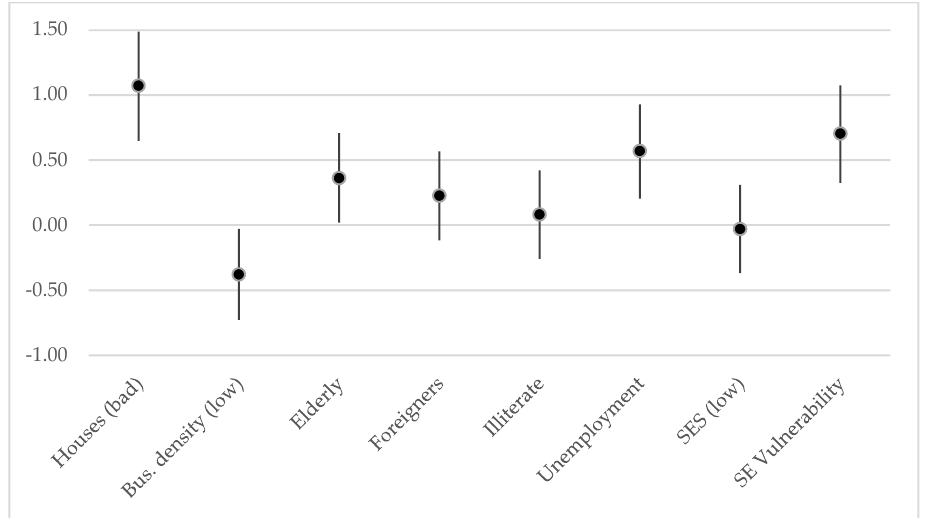
Figure 1. URBAN Initiative: differences between chosen and non-chosen areas. Effect sizes: Hedges’ g (95% confidence interval).